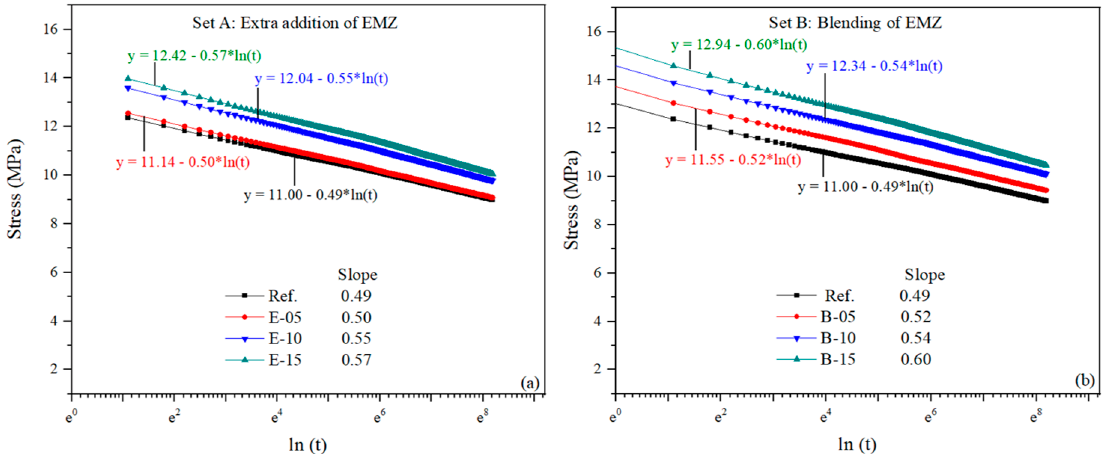
Figure 7. Stress relaxation curves as a function of EMZ loading levels of silica-filled NR vulcanizates. EMZ was added via either extra addition (Set A) or blending (Set B) .